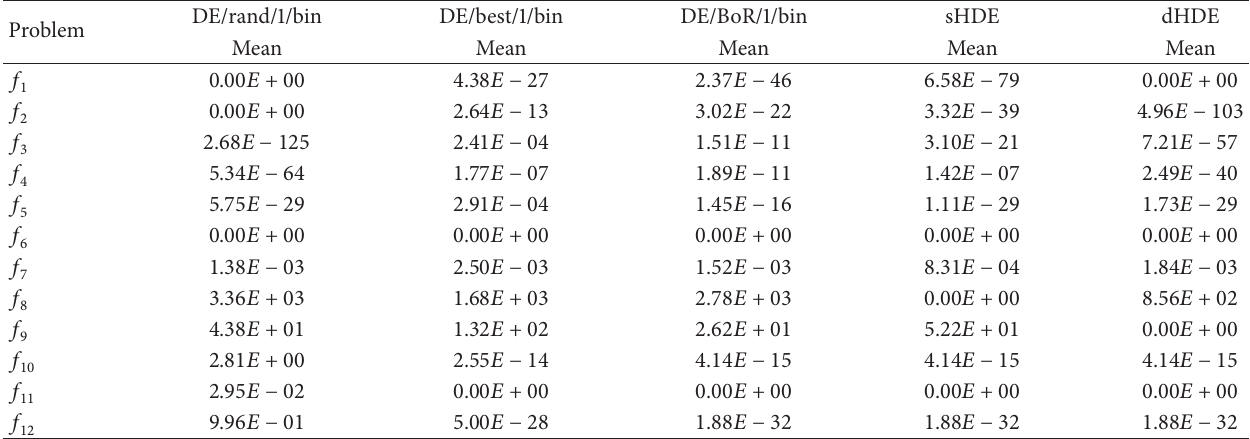
Table 3: Comparison of HDE with jDE, NSDE, and DEGL on classical benchmark problems. jDE NSDE Problem